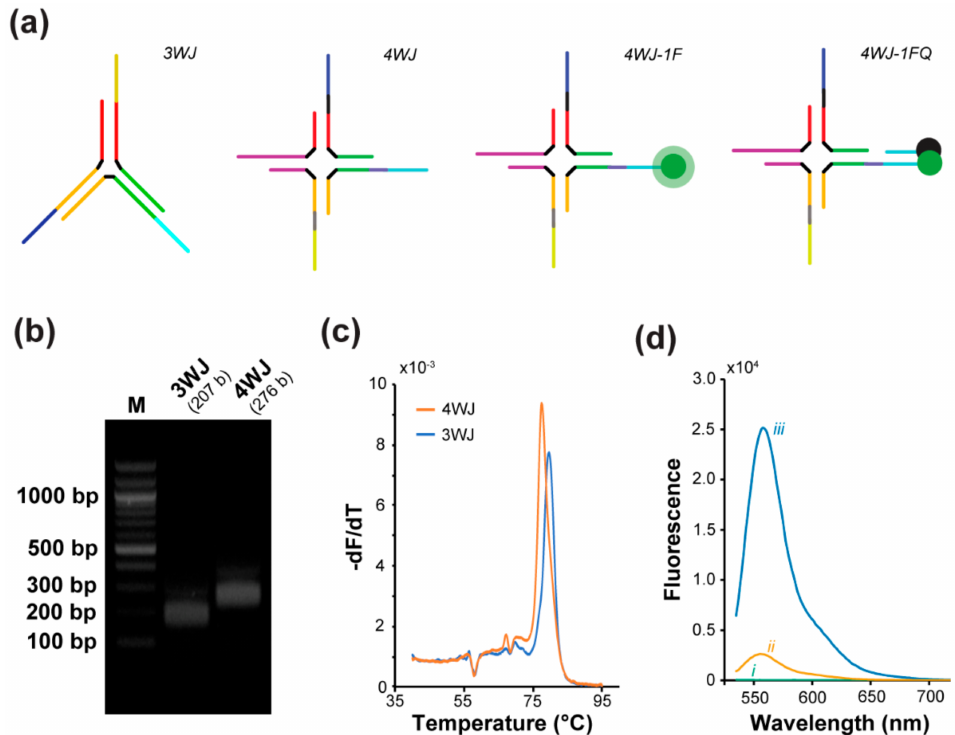
Figure 2. DNA nanostructures characterization. ( a ) Schematic of the bare 3WJ, 4WJ, 4WJ with one fluorophore (4WJ-1F), and 4WJ with one fluorophore and one quencher (4WJ-1FQ) design. ( b ) 1.5 wt% agarose gel electrophoresis for both bare 3WJ and 4WJ. ( c ) The melting curve for both bare 3WJ and 4WJ. ( d ) Fluorescence characterization of the different 4WJ states. (i) 4WJ, (ii) 4WJ-1FQ, and (iii)